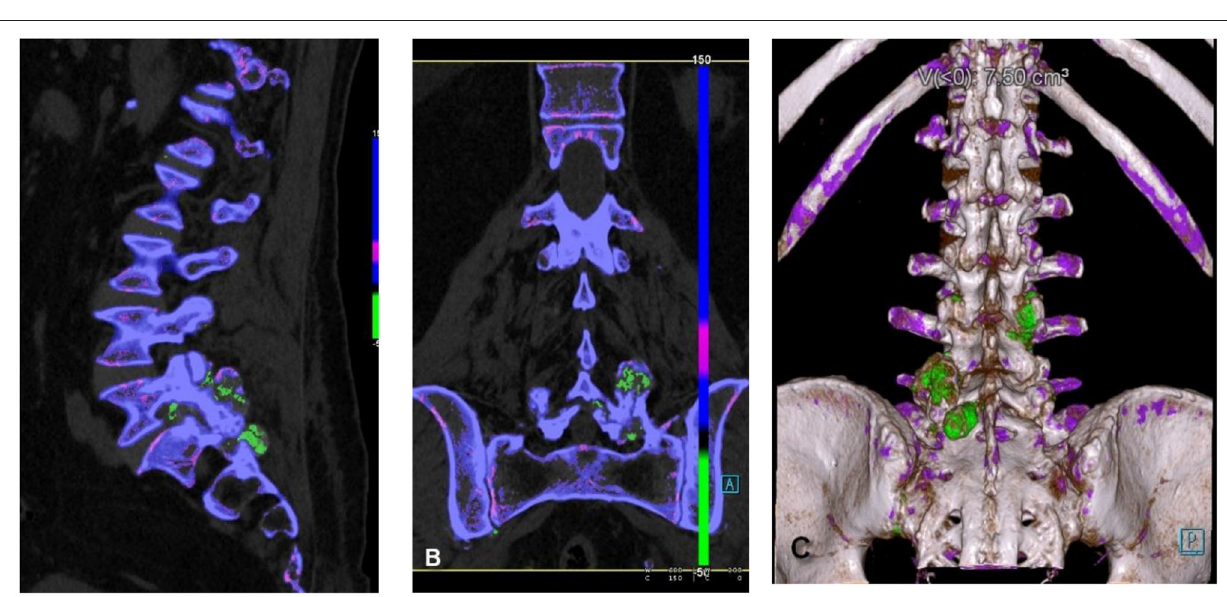
Frontiers in Medicine |